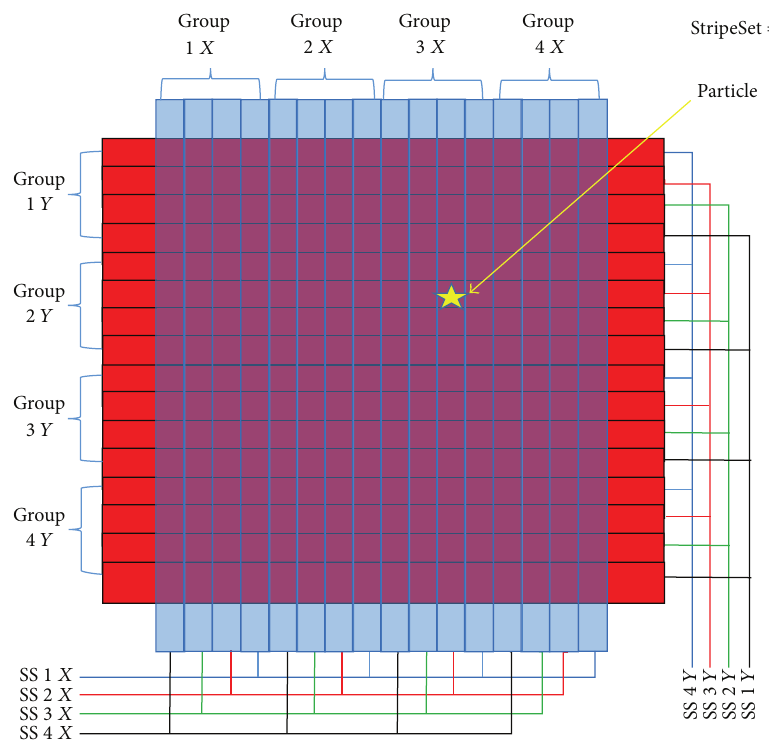
Figure 2: An example of the application of the channel reduction system.